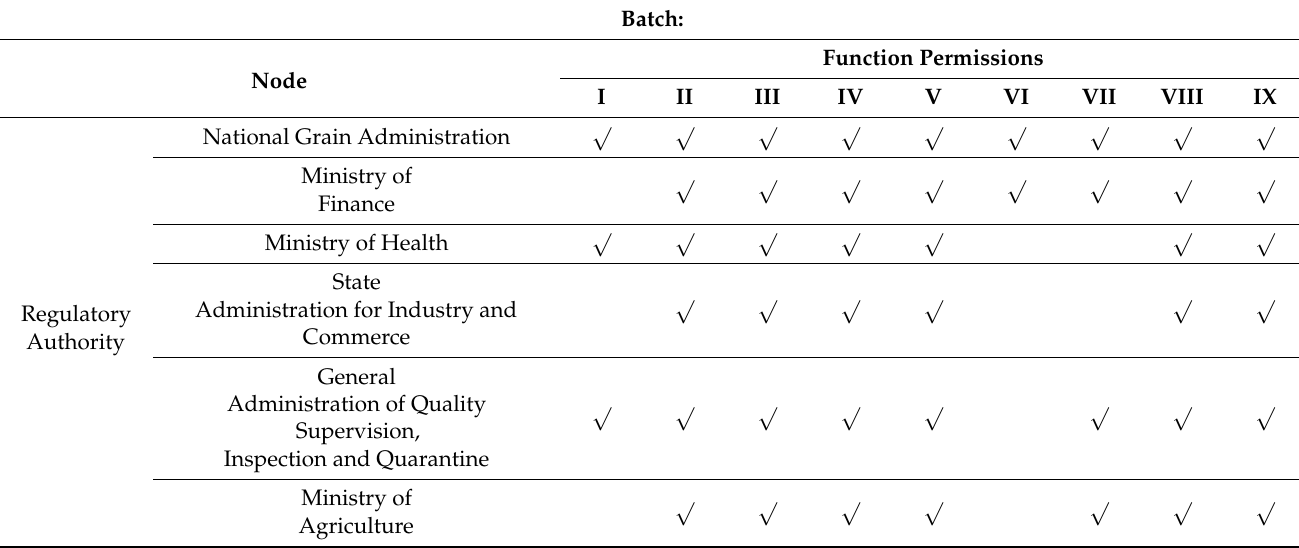
Table 3. Permission data